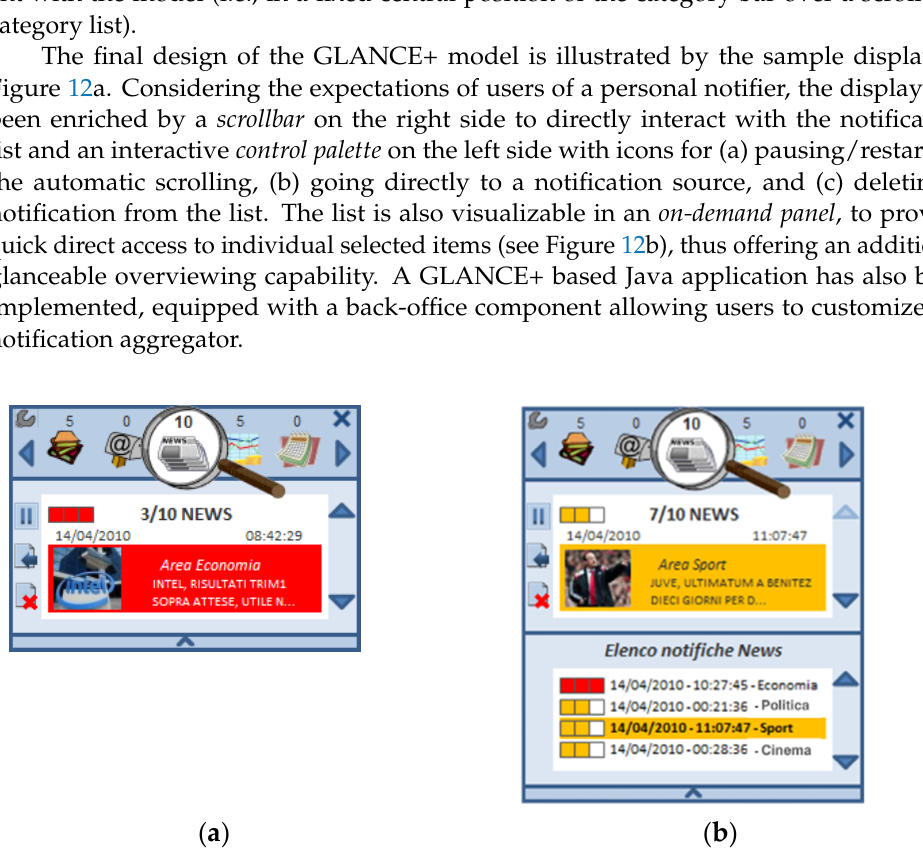
Figure 12. The final design of the GLANCE+ model, with ( a ) the notification component, and ( b ) the notification list visualized in the on-demand panel.